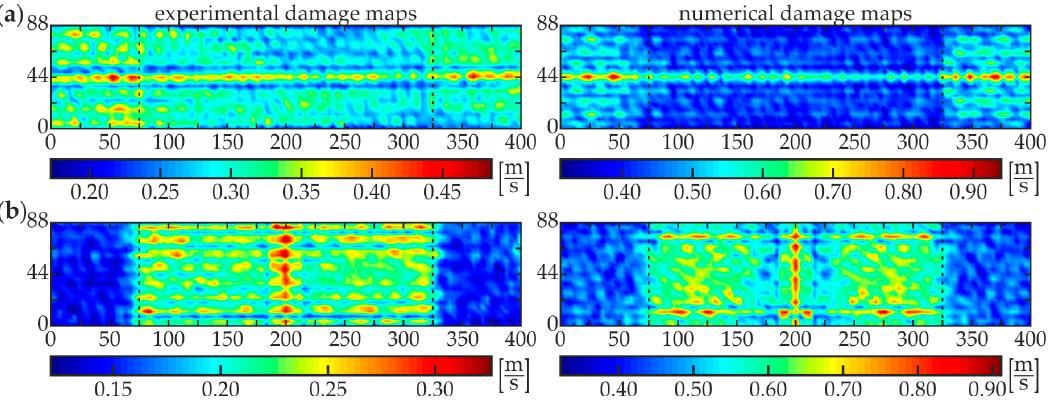
Figure 12. Experimental and numerical WRMS damage maps for specimen #4: ( a ) excitation P3 and ( b ) excitation P4.